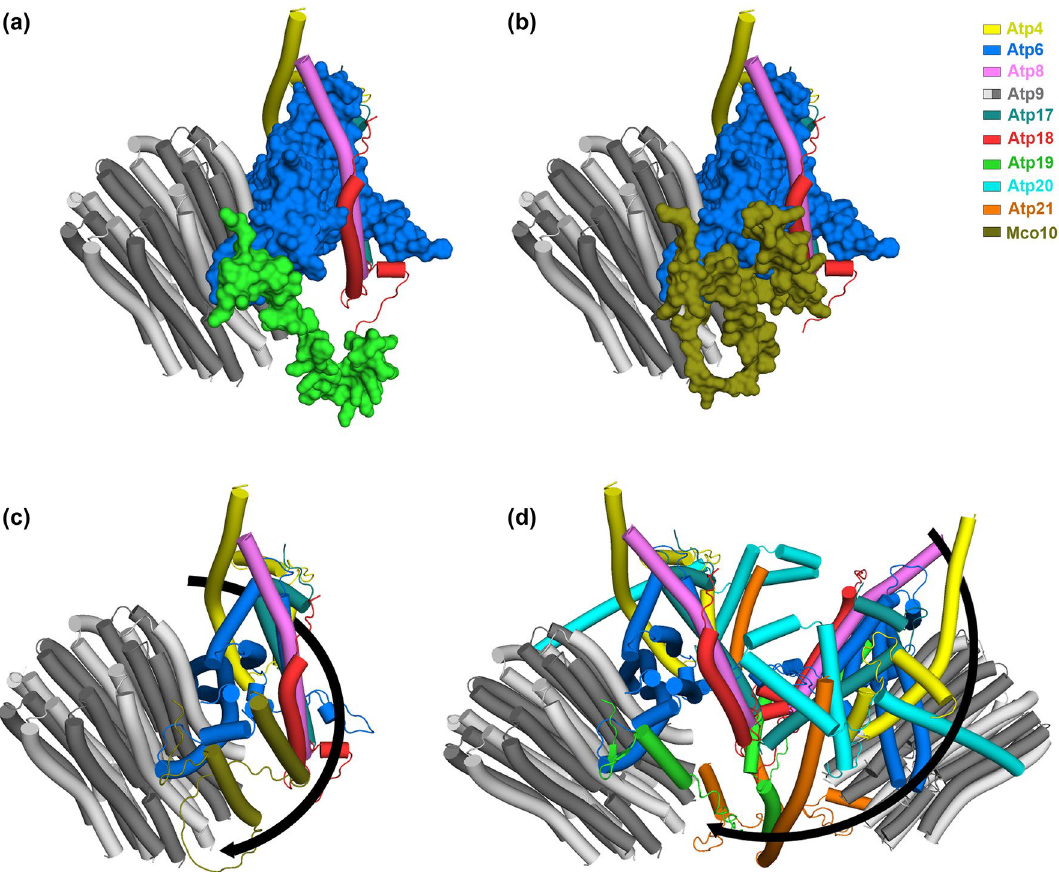
Figure 8. Remodeling of ATP synthase Fo region with AlphaFold2 predicted structures of the Fo subunits using PDB 6B8H as template and visualized in PyMOL. ( a ) Partial reconstruction of the Fo region showing b / Atp4 (membrane part), k /Atp19, i /Atp18, a /Atp6. ( b ) k /Atp19 is replaced by Mco10 in the model. ( c ) The PTP signal transduction pathway to the c -ring within the monomer of ATP synthase via b, f , 8 , i , Mco10, indicated by black arrow. ( d ) The PTP signal transduction pathway within the dimer of ATP synthase dependent on g /Atp20, e /Atp21 but not k /Atp21 (the b-g-e